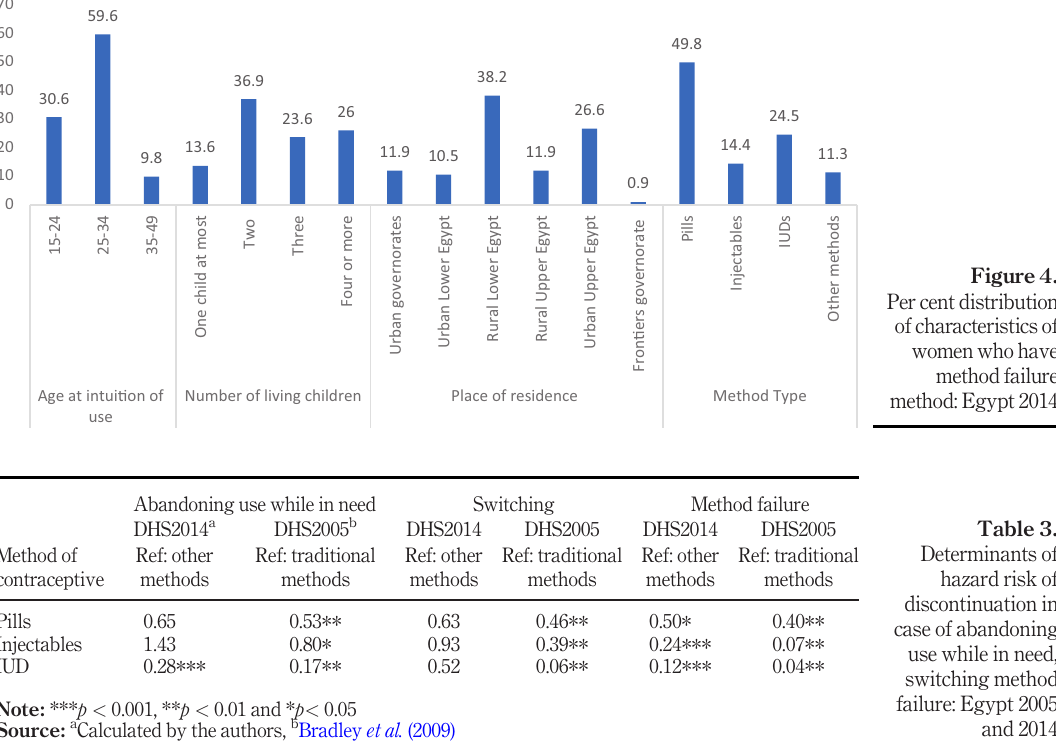
Figure 4. Per cent distribution of characteristics of women who have